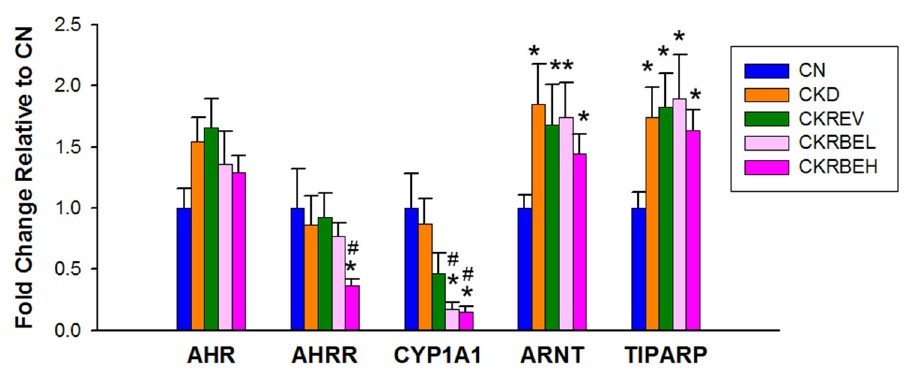
Figure 4. Effect of adenine-induced chronic kidney disease (CKD), resveratrol, or resveratrol butyrate